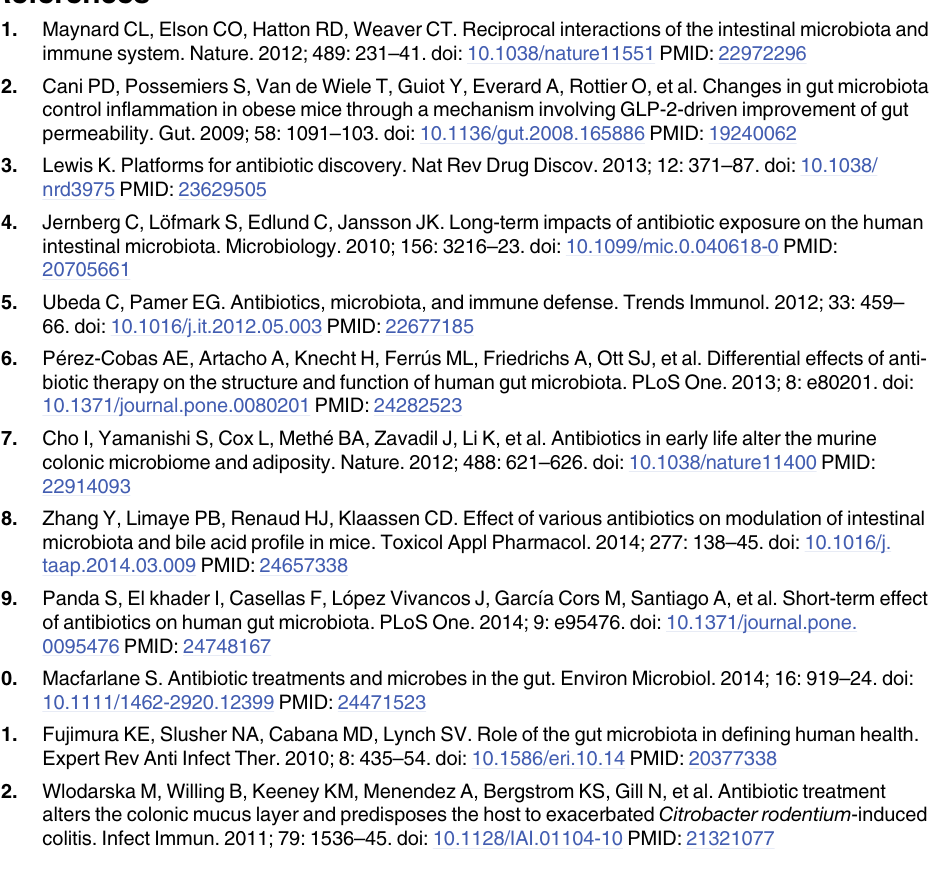
S3 Fig. Gene expression of intestinal permeability markers. Mean relative gene expression of (A) claudin-1, (B) occludin, (C) ZO-1 and (D) Muc2 in tissue samples obtained from the colon of animals in CON,control (grey); AMX, amoxicillin (blue); CTX, cefotaxime (green); VAN, vancomycin (yellow) and MTZ, Metronidazole (red) groups. Error bars show SEM. No signifi- cant differences between antibiotic groups and the control group were found.